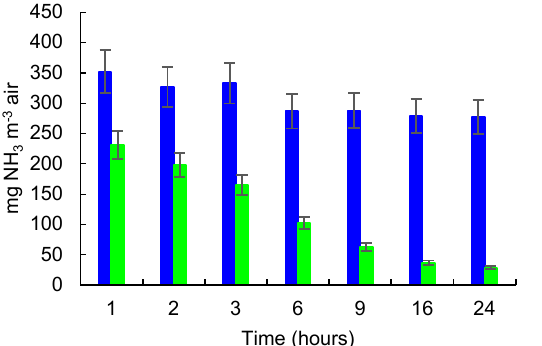
Figure 5. NH 3 released/adsorbed from 0.5 mL NH 4 OH solution 25%. NH 3 concentration (mg m − 3 ) in control box (blue color) and in box with zeolite (green color); error bars for 10% Ue rel are shown.